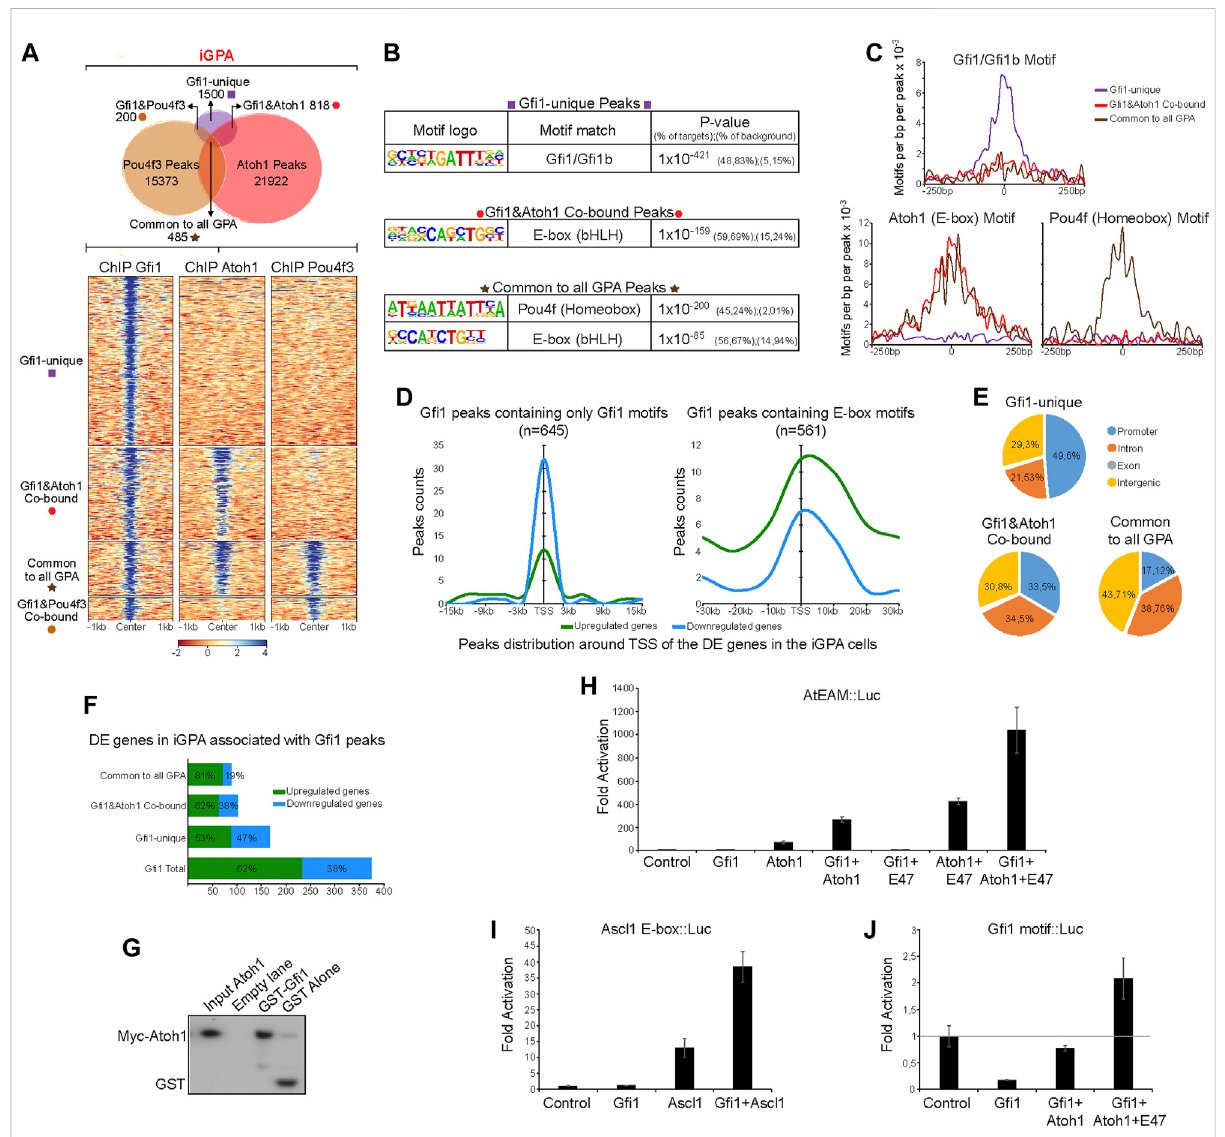
G fi 1 unique sites are enriched in G fi 1 motifs but G fi 1/Atoh1 cobound sites are enriched in E boxes. (A) Upper: Venn diagram showing the peaks overlap between G fi 1, Pou4f3, and Atoh1 ChIP-seq in iGPA EBs. Lower: Density heatmaps of G fi 1, Atoh1, and Pou4f3 ChIP-seq obtained from iGPA EBs 48 h post-induction of TF overexpression. The heatmap is divided by non-overlapping and overlapping peaks across these 3 ChIP-seq datasets asrepresentedintheupperVenndiagram. (B) denovo motifsanalysesshowingthemostsigni fi cantmotifsfoundinG fi 1ChIP-seqdatasetwhich was divided by G fi 1-unique peaks, G fi 1&Atoh1 co-bound and G fi 1&Atoh1&Pou4f3 co-bound (common to all GPA) peaks. (C) Frequency and distribution of G fi 1, Ebox, and Pou4f homeobox motifs across a 250 bp interval surrounding G fi 1 peak centres for each G fi 1 unique and overlapping peak groups. G fi 1 mo fi fs are highly enriched in the G fi 1-unique peaks but not in G fi 1 overlapping peaks where Ebox and homeobox motifs are enriched. (D) G fi 1 peaks divided by either containing G fi 1 motifs or Ebox motifs were associated with gene repression (blue) or activation (green) among the DE genes found in iGPA EBs. Smooth curves show higher numbers of peaks containing G fi 1 motifs associated with gene repression only close to TSS. In contrasts, the majority of G fi 1 peaks containing Ebox are associated with gene activation both close and outside (+/30 kb) of TSS. (E) Pie charts showing the location of G fi 1 unique and overlapping peak relative to several genomic features. (F) Percentages and numbers of downregulated and upregulated genes among the DE genes in iGPA EBs associated with G fi 1 peaks detected in iGPA cells. (G) GST pull-down analysis ofMyc-tagged Atoh1 withGST-taggedG fi 1.Western blotprobedwith anti-Myc antibody. (H) Expression analysisofluciferasereportergene under control of multimerised Atoh1 (AtEAM) motifs in cells cotransfected with expression vectors for G fi 1, Atoh1 and/or E47 (control is cotransfectionwithemptyexpressionvector).Foldactivationshownisrelativetocontrol.ThedatawithE47arefromaseparateexperimentfromthe datawithoutE47. (I) Similarto (H) butwithaluciferasereportergeneundercontrolofmultimerisedAscl1motifs. (J) Similarto (H) butwithaluciferase reporter gene under control of multimerised G fi 1 binding